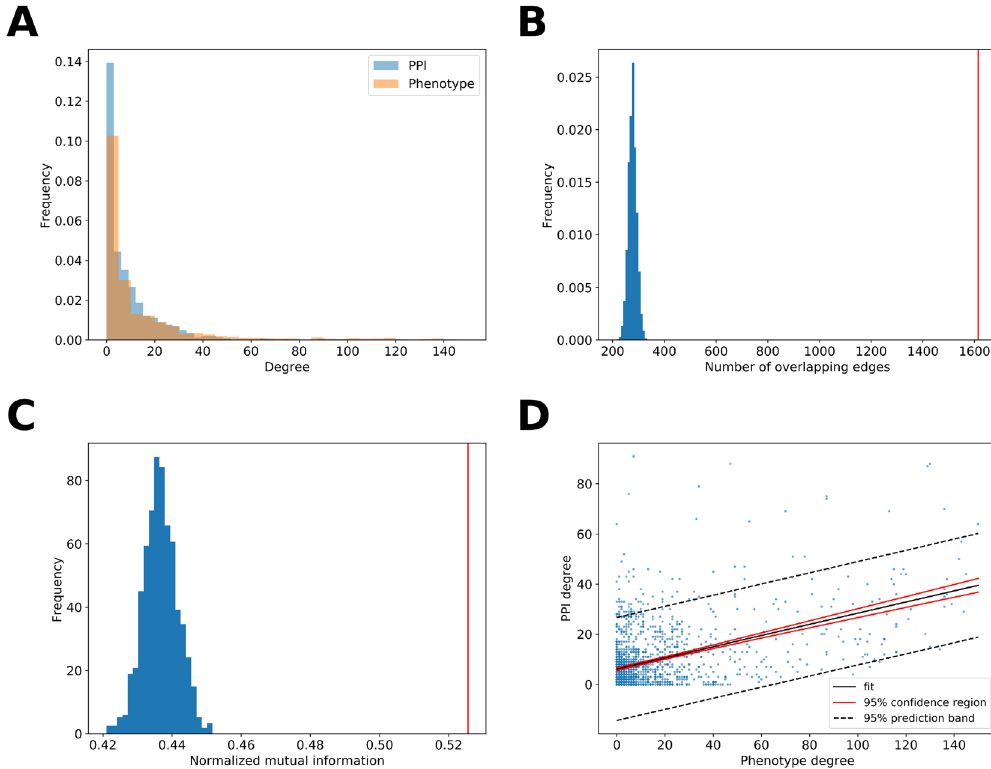
Figure 2. Similarity of the PPI and phenotype network layers in the epilepsy-autism multiplex network. ( A ) The degree distribution within each layer of the multiplex network is plotted. ( B ) There is a significant number of edges overlapping between the PPI network layer and phenotype network layer (p < 0.0001). The distribution represents the number of overlapping edges from 10,000 trials where the PPI network and phenotype network were randomly generated maintaining their original degree distribution. The red line represents the actual number of overlapping edges between the two networks. ( C ) There is a significant overlap in the modules in the PPI network layer and the modules in the phenotype network layer (p < 0.001). The distribution represents the normalized mutual information from 1000 trials where the PPI network and phenotype network were randomly generated maintaining their original degree distribution. The red line represents the actual normalized mutual information. ( D ) There is a correlation between the degree of a node in the PPI network layer and phenotype network layer. Each point represents one of the 1707 genes/nodes in the multiplex